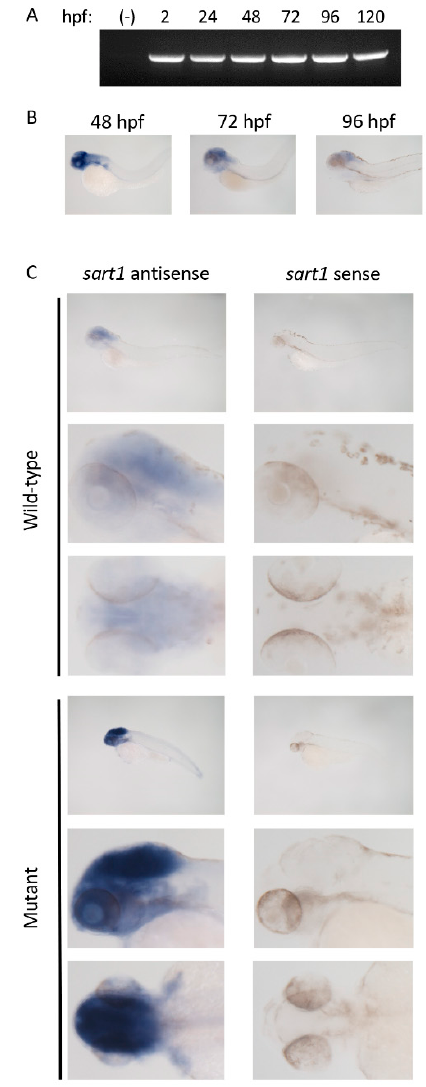
Figure 4. RT PCR and whole mount in situ hybridization identifies sart1 expression. ( A ) RT-PCR shows sart1 expression from 2 hpf to 120 hpf in zebrafish larvae including a water negative control (-). ( B ) Whole mount in situ hybridization shows sart1 expression localized to the brain at 48 hpf, 72 hpf, and 96 hpf. ( C ) Whole mount in situ hybridization shows localization and relative expression levels of sart1 in cp27.5 wild-type and mutant larvae at 72 hpf. Images are ordered as lateral view at low magnification, lateral view at high magnification, and dorsal view at high magnification for both antisense (left column) and sense (right column). Scale bars are 50 µ